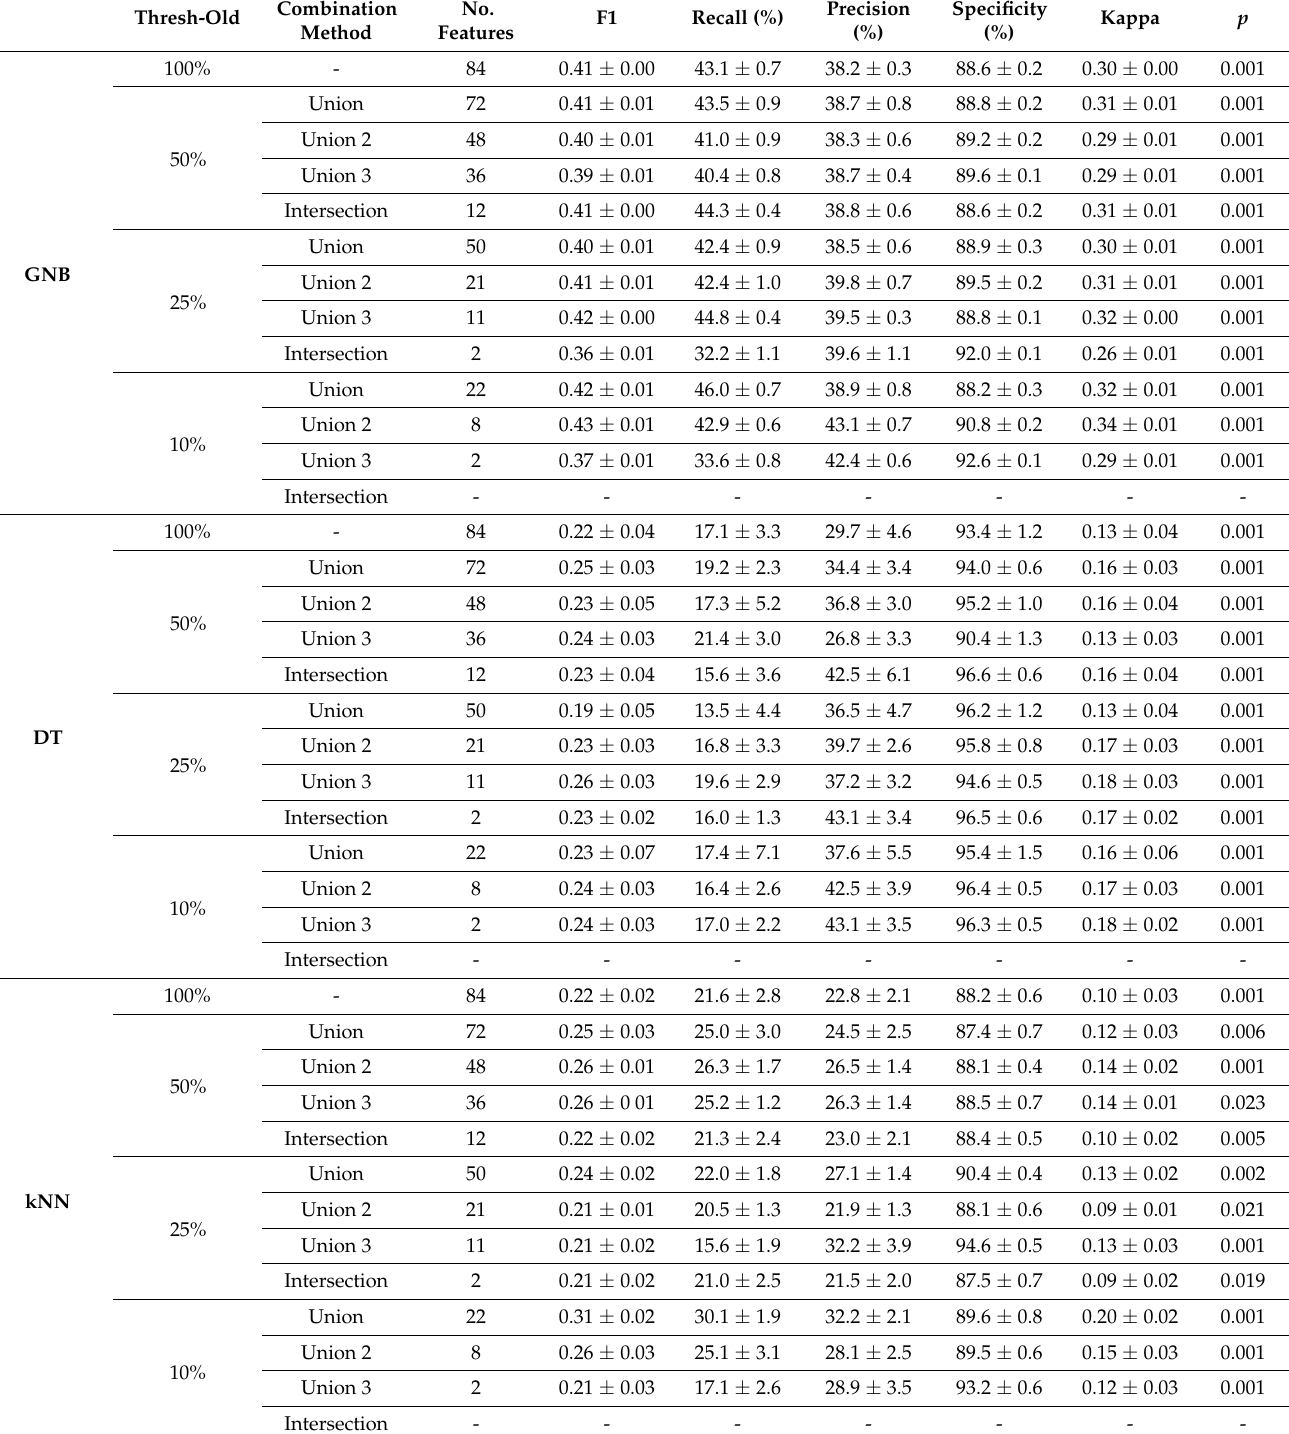
Table A7. Performance of the four classification models on detection fall using Mobility Lab Gait normal walking data set ; Gaussian Naive Bayes (GNB); Decision Tree (DT); k-Nearest Neighbor (kNN); Support Vector Machine (SVM); p -value via permutation